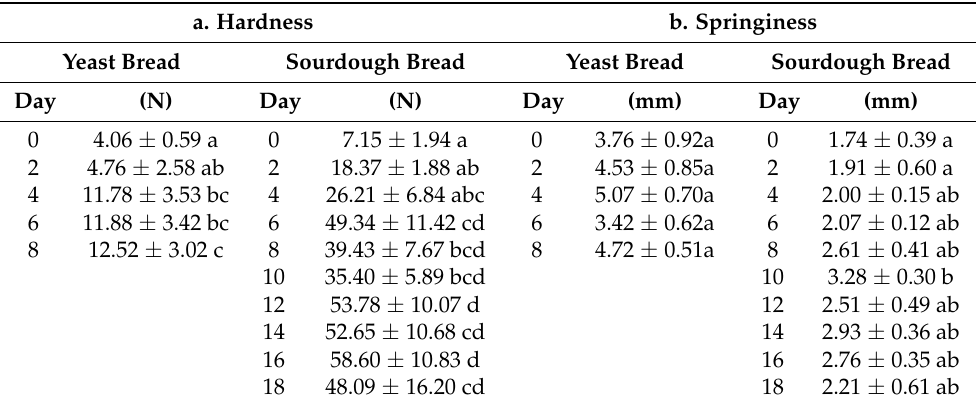
Table 4. The effect of storage time on (a) hardness and (b) springiness development of yeast and sourdough bread stored at 25 ◦